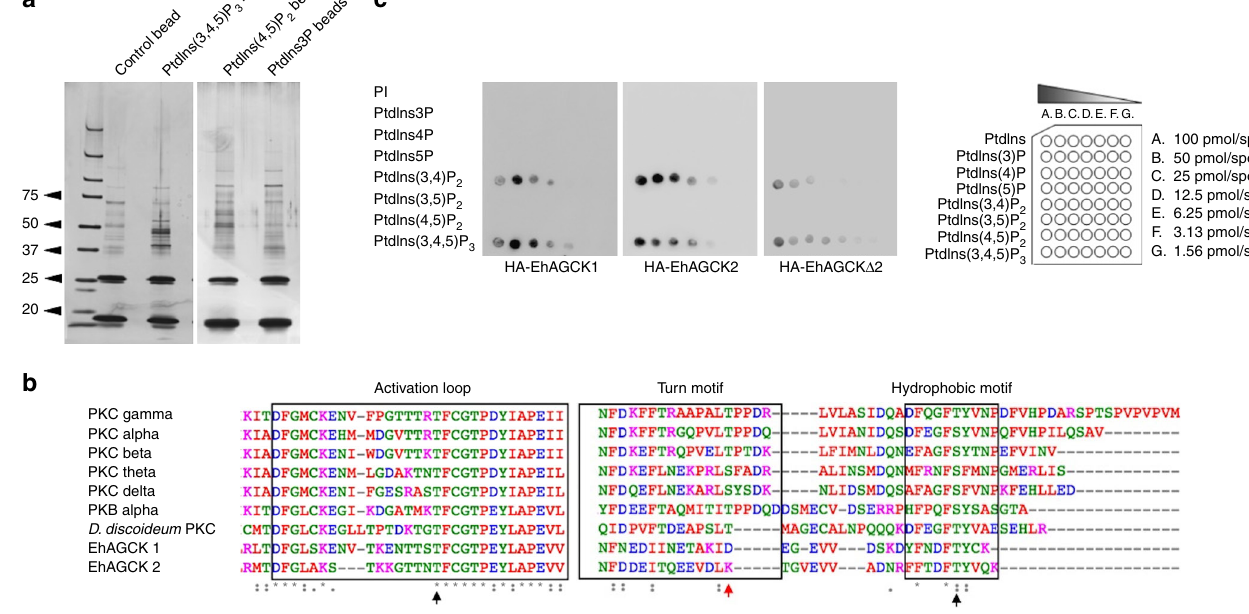
Fig. 1 Identi fi cation of PtdIns(3,4,5)P 3 -binding proteins. a Proteins eluted from PtdIns(3,4,5)P 3 , PtdIns(4,5)P 2 , PtdIns3P and lipid-free control beads were resolved on SDS-PAGE gel followed by silver staining. b Lipid overlay assay with HA-tagged proteins expressed in E. histolytica trophozoites. c Multiple sequence alignment with various PKC isoforms from human and protein kinase from D. discoideum showing important conserved phosphorylation sites in EhAGCK1 and EhAGCK2 activation loop and hydrophobic motif (marked by black arrow ). The conserved phosphorylation site is absent in the turn motif of both proteins (marked by red arrow